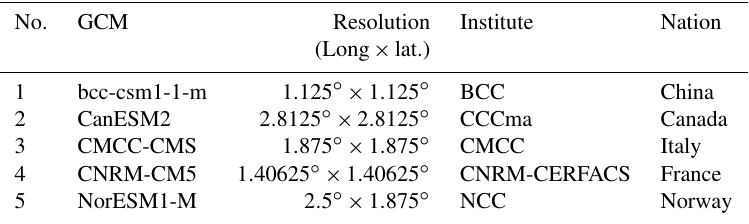
Table 2. List of the five selected GCMs used in this study. No. GCM Resolution Institute Nation (Long × lat.) 1 bcc-csm1-1-m 1 . 125 ◦ × 1 . 125 ◦ BCC China 2 CanESM2 2 . 8125 ◦ × 2 . 8125 ◦ CCCma Canada 3 CMCC-CMS 1 . 875 ◦ × 1 . 875 ◦ CMCC Italy 4 CNRM-CM5 1 . 40625 ◦ × 1 . 40625 ◦ CNRM-CERFACS France 5 NorESM1-M 2 . 5 ◦ × 1 . 875 ◦ NCC